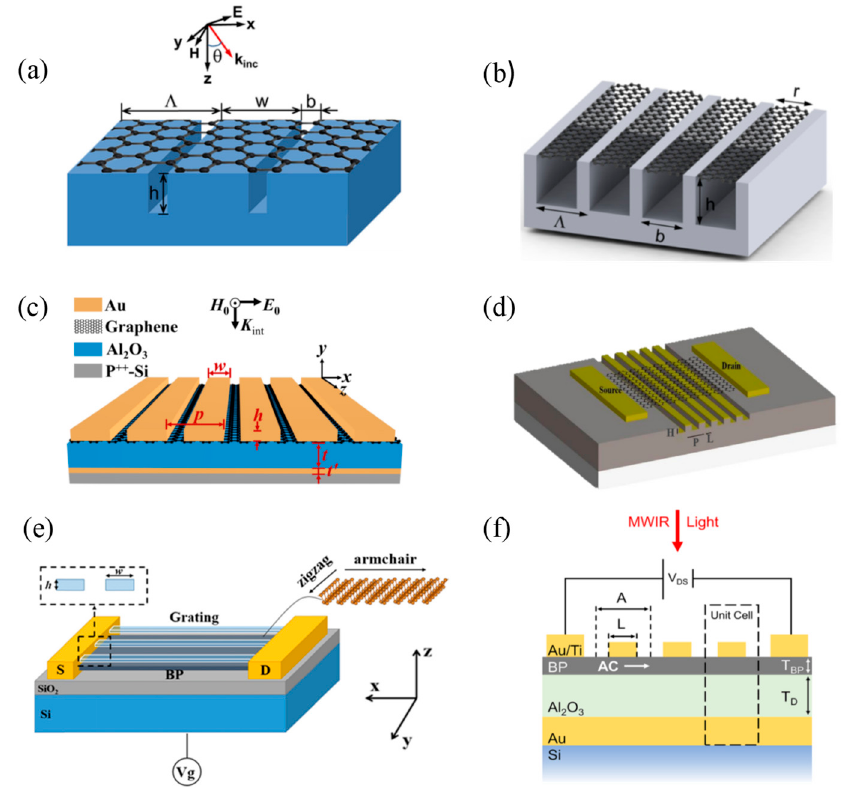
Figure 6. Structures of 1D materials-based infrared PDs with grating structures. ( a ) Schematic of the graphene-covered deep Ag grating [51]. Copyright 2014, Applied Physics Letters . ( b ) Schematic of the hybrid grating-graphene ribbon plasmonic structure under plane wave incidence [52]. Copyright 2015, ACS Photonics. ( c ) Schematic structure of the graphene-based PD [53]. Copyright 2018, Optics Express . ( d ) Schematic diagram of the structure of a metamaterial integrated graphene PD device. The metamaterial is designed as a grating structure [54]. Copyright 2019, Applied Surface Science. ( e ) Schematic diagram of 20-layer BP-based PD [55]. Copyright 2019, Optical Materials Ex- press . ( f ) Schematic diagram of the proposed device with a raster structure and only three individ- ual unit cells [56]. Copyright 2022, Nano Le tt ers.